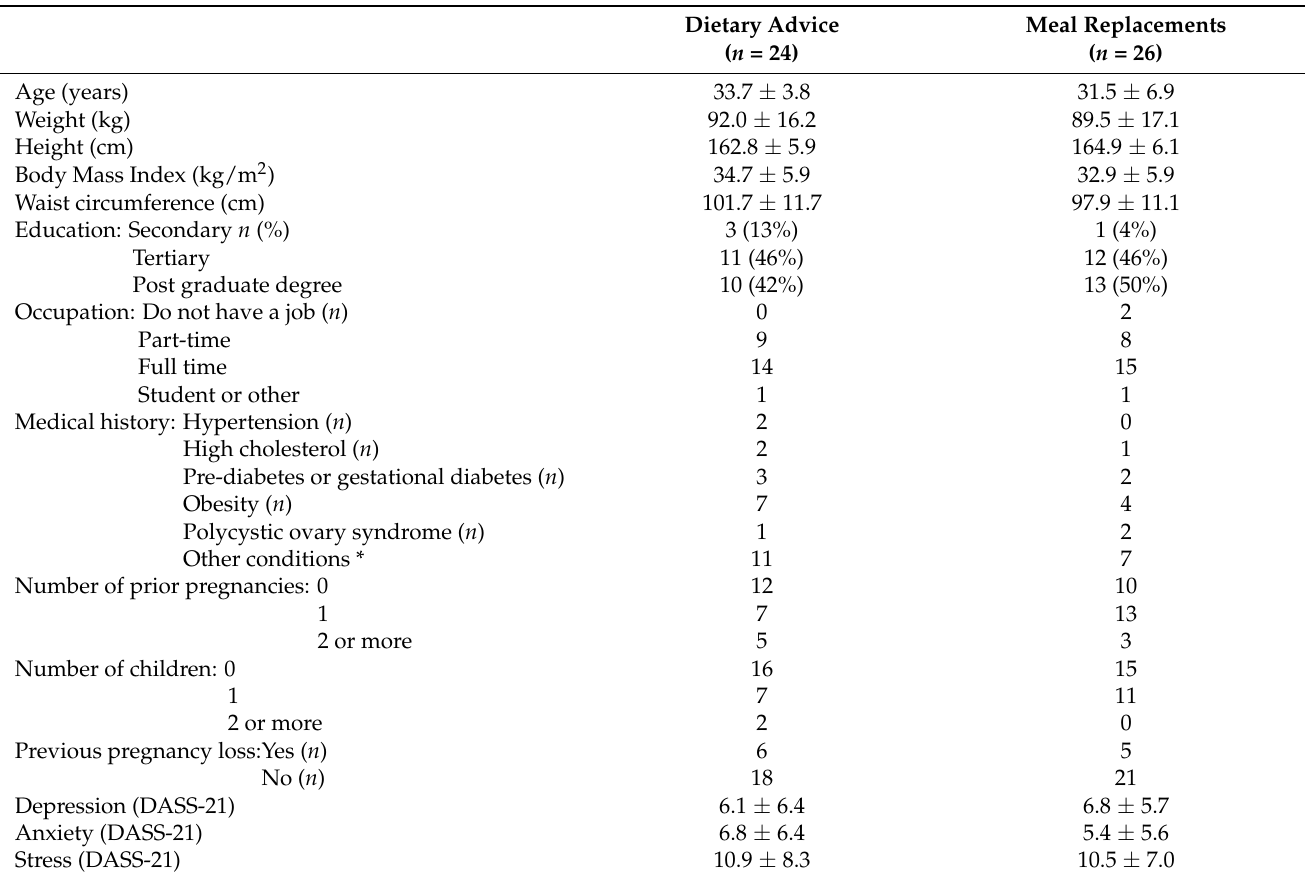
Table 2. Baseline participant characteristics in the two intervention groups.